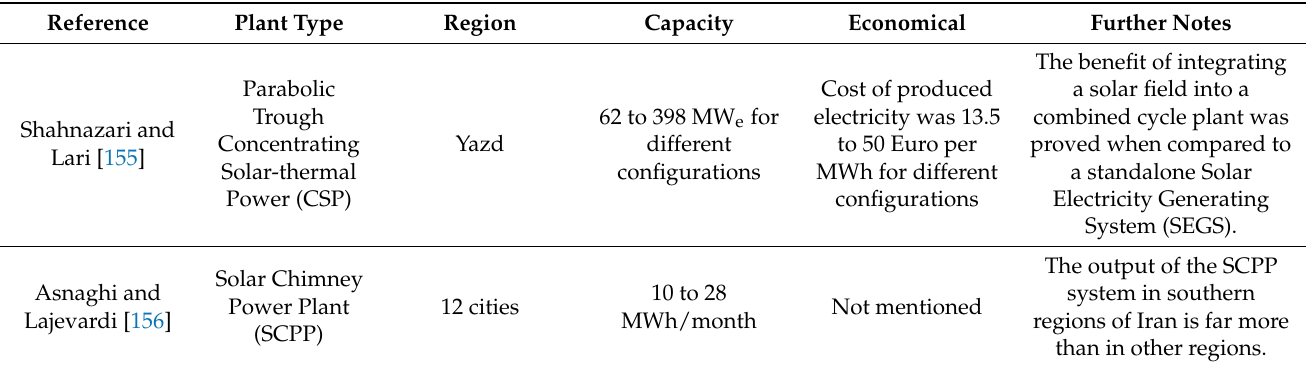
Table 5. Designed solar power plants for different regions in